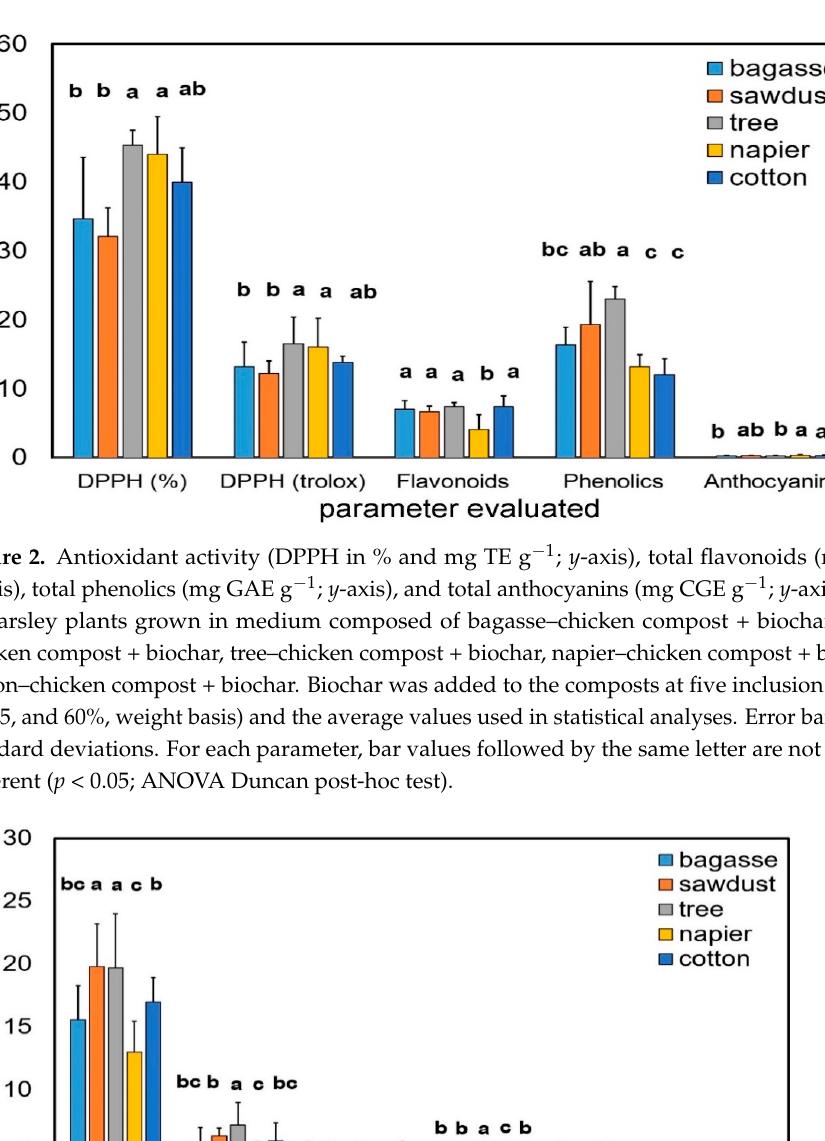
Figure 2. Antioxidant activity (DPPH in % and mg TE g − 1 ; y -axis), total flavonoids (mg CE g − 1 ; y - axis), total phenolics (mg GAE g − 1 ; y -axis), and total anthocyanins (mg CGE g − 1 ; y -axis) in shoots of